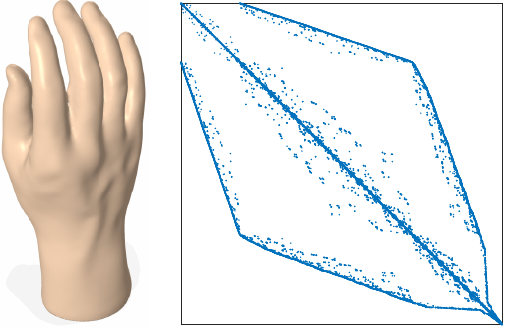
Figure 1. Hand model ( left ) and sparsity pattern plot of its weighted Laplacian matrix ( right